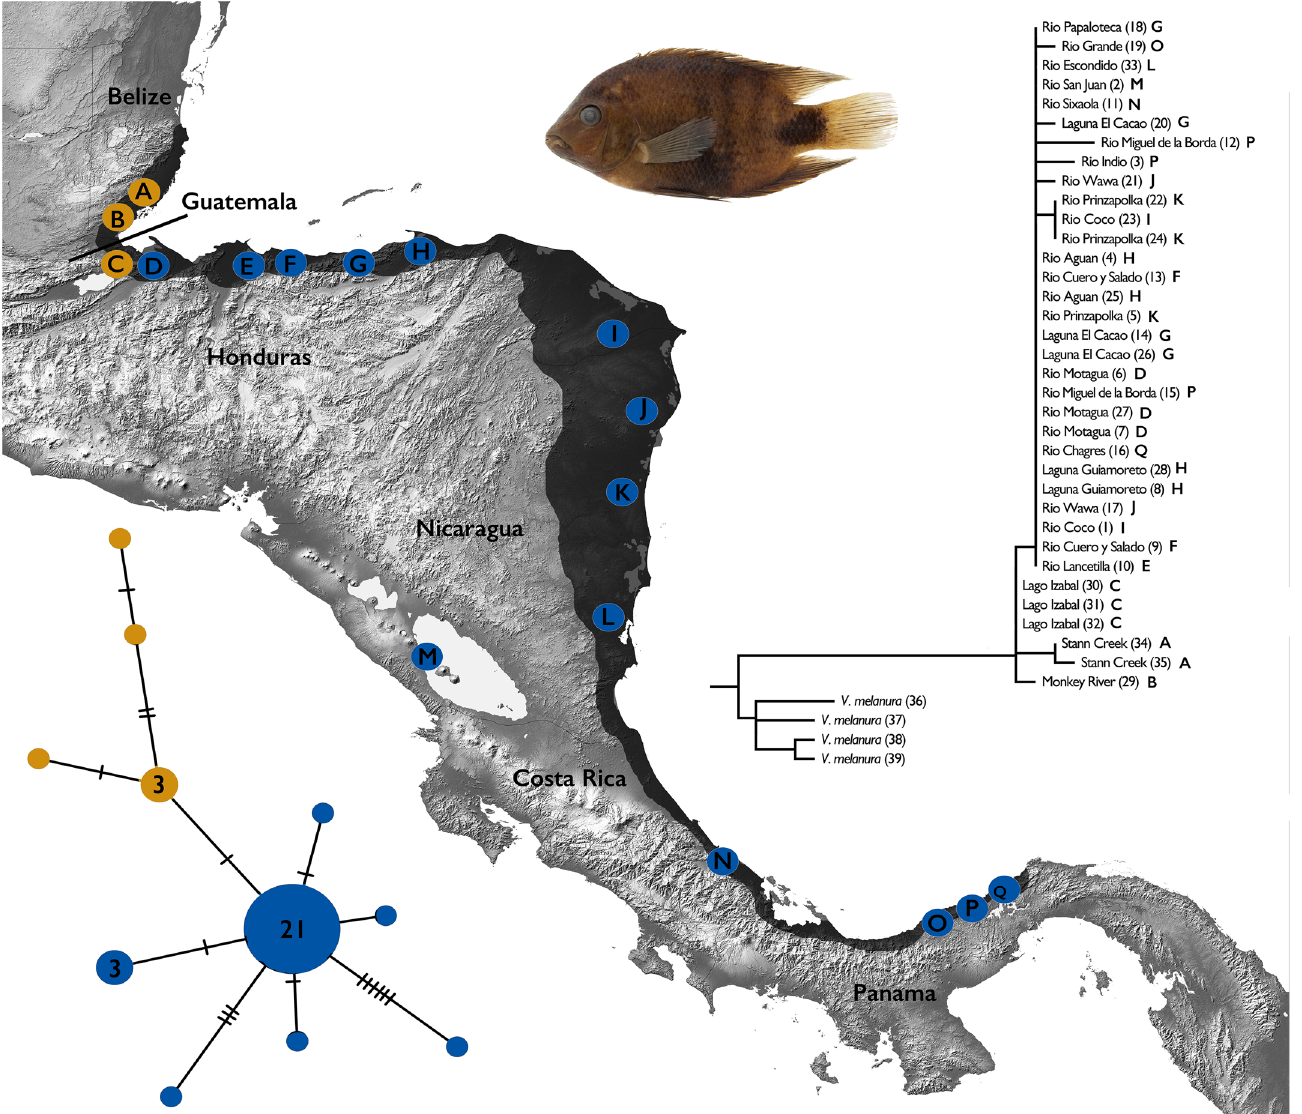
Fig 1. Distribution, sampling localities, and phylogeographic results for Vieja maculicauda . Distributionof V . maculicauda shown in shaded area on map, including Lago Nicaragua. Dots on map represent samplinglocalitiesfor specimens used in phylogeneticand haplotypeanalyses. Numbers beside localities on the Bayesianphylogenetic tree correspond to list of samplesin Table 1; letters correspondto localities on map. Numbers in haplotypenetwork indicatenumber of individuals with that haplotype; circles without numbers equalone individual.Haplotypecolors correspondto geographicpatterns north and south of the area of the